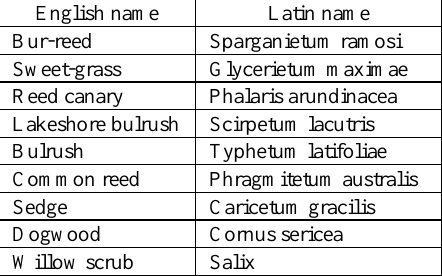
Table 1. Main vegetation